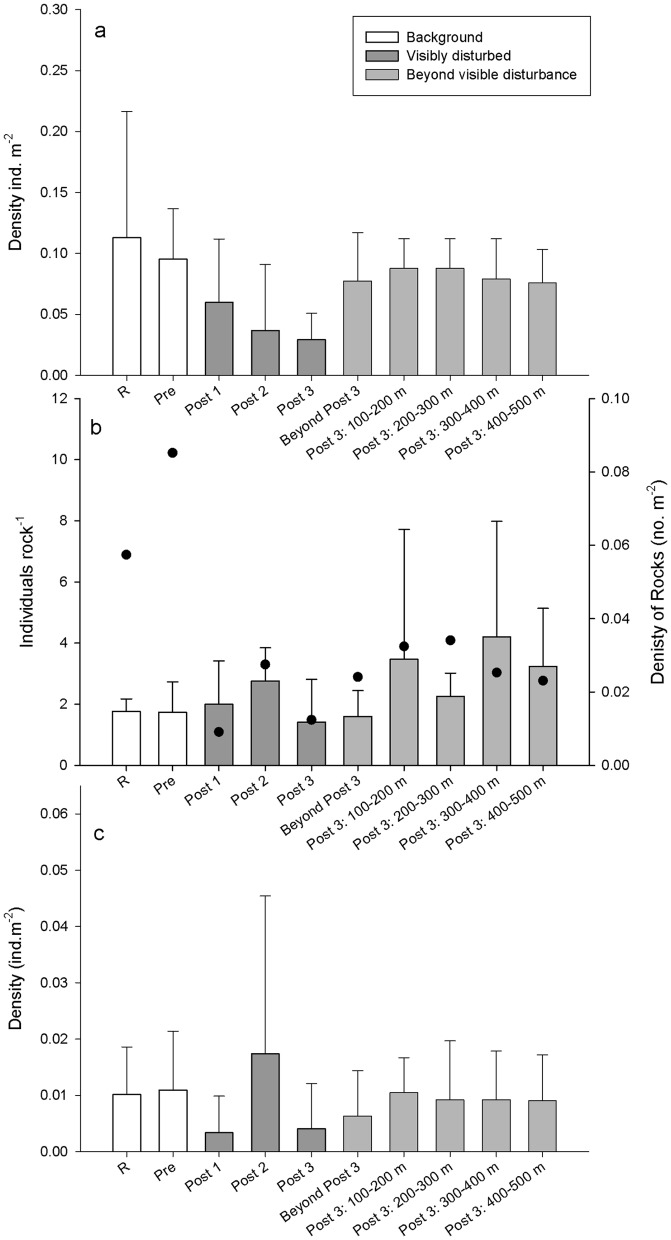
Mean (±sd) megafaunal invertebrate density (individuals m−2) at Morvin.(a) soft sediment, (b) hard substrate and (c) generalist megafauna. Background sites are shown in white, visibly disturbed areas in dark grey and areas beyond disturbance are shown in light grey. Filled circles in hard substratum chart present show the density of rocks in the transects.